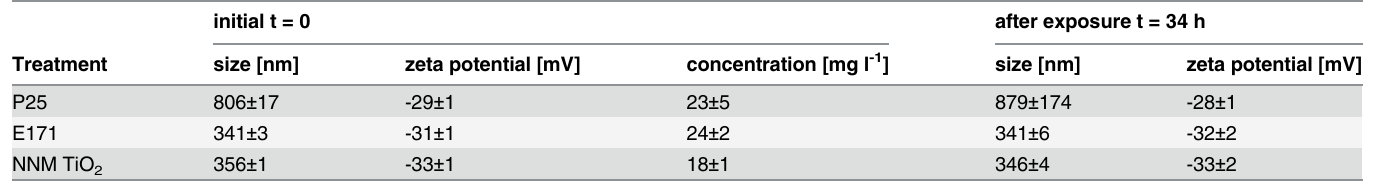
Table 1. Analytical data of the TiO 2 NPs suspended in YMB medium. Suspensions for the R . trifolii exposure experiment were assessed at the start of the experiment (t = 0) and at the end, i.e., after 34 h (n = 3). initial t = 0